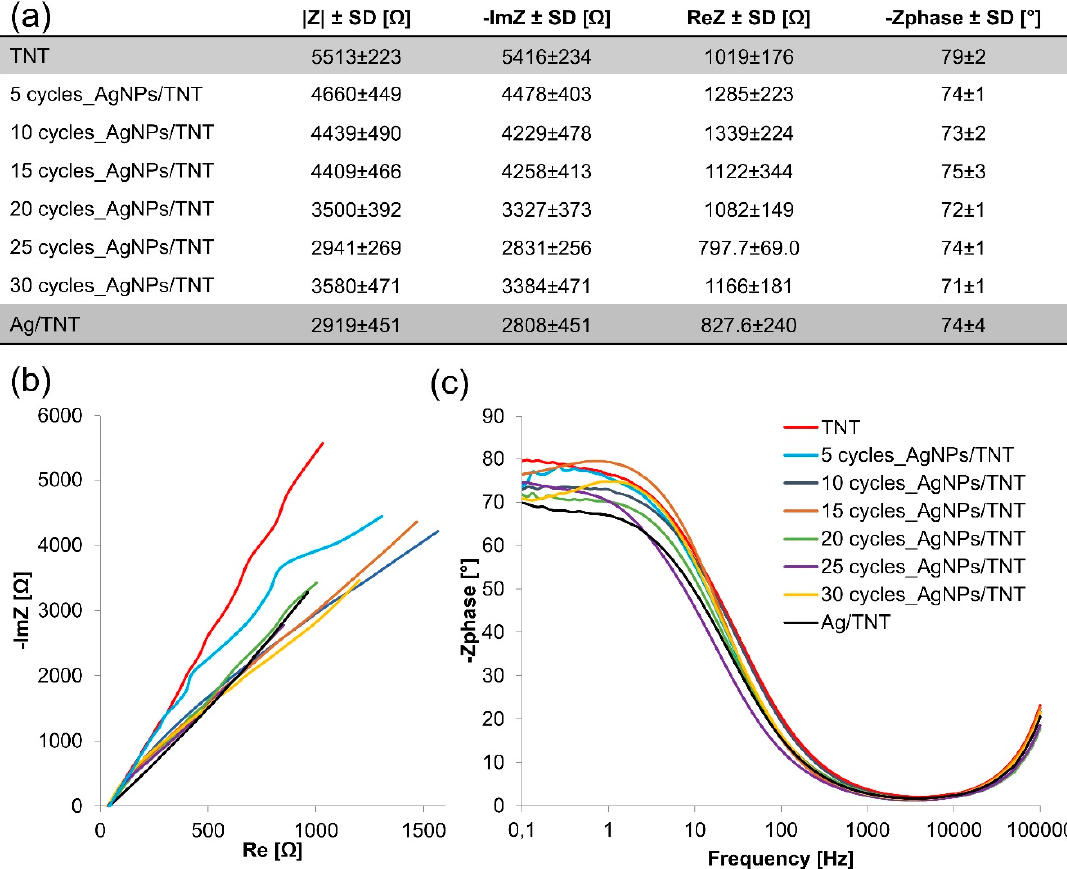
Figure 3. Chart presenting a number of deposition cycles dependence on silver weight content in produced AgNPs/TNT platforms.